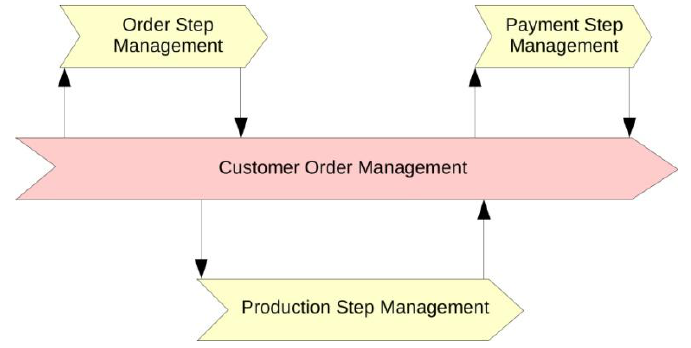
Figure 4. Process Map (1st Normal